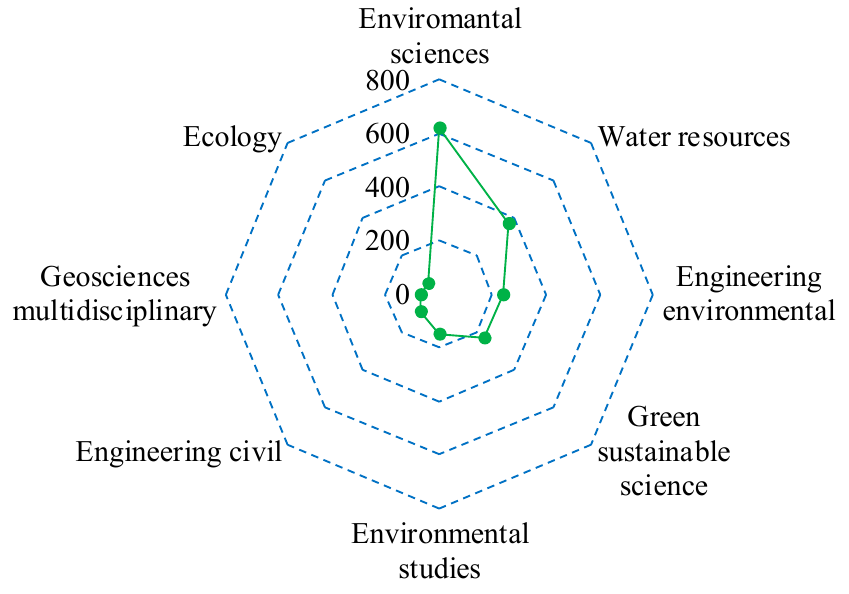
Figure 2. The number of publications in different subjects.